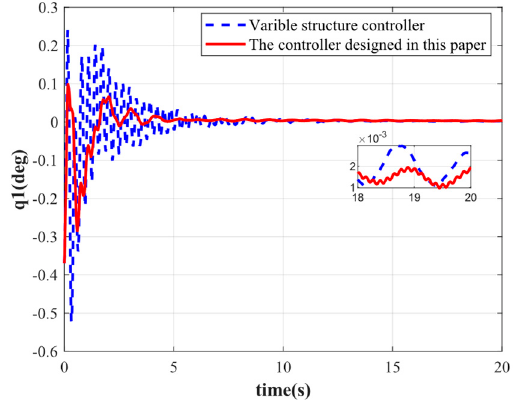
Figure 5. First ‐ order elastic vibration mode without external interference. Figure 5. First-order elastic vibration mode without external interference.